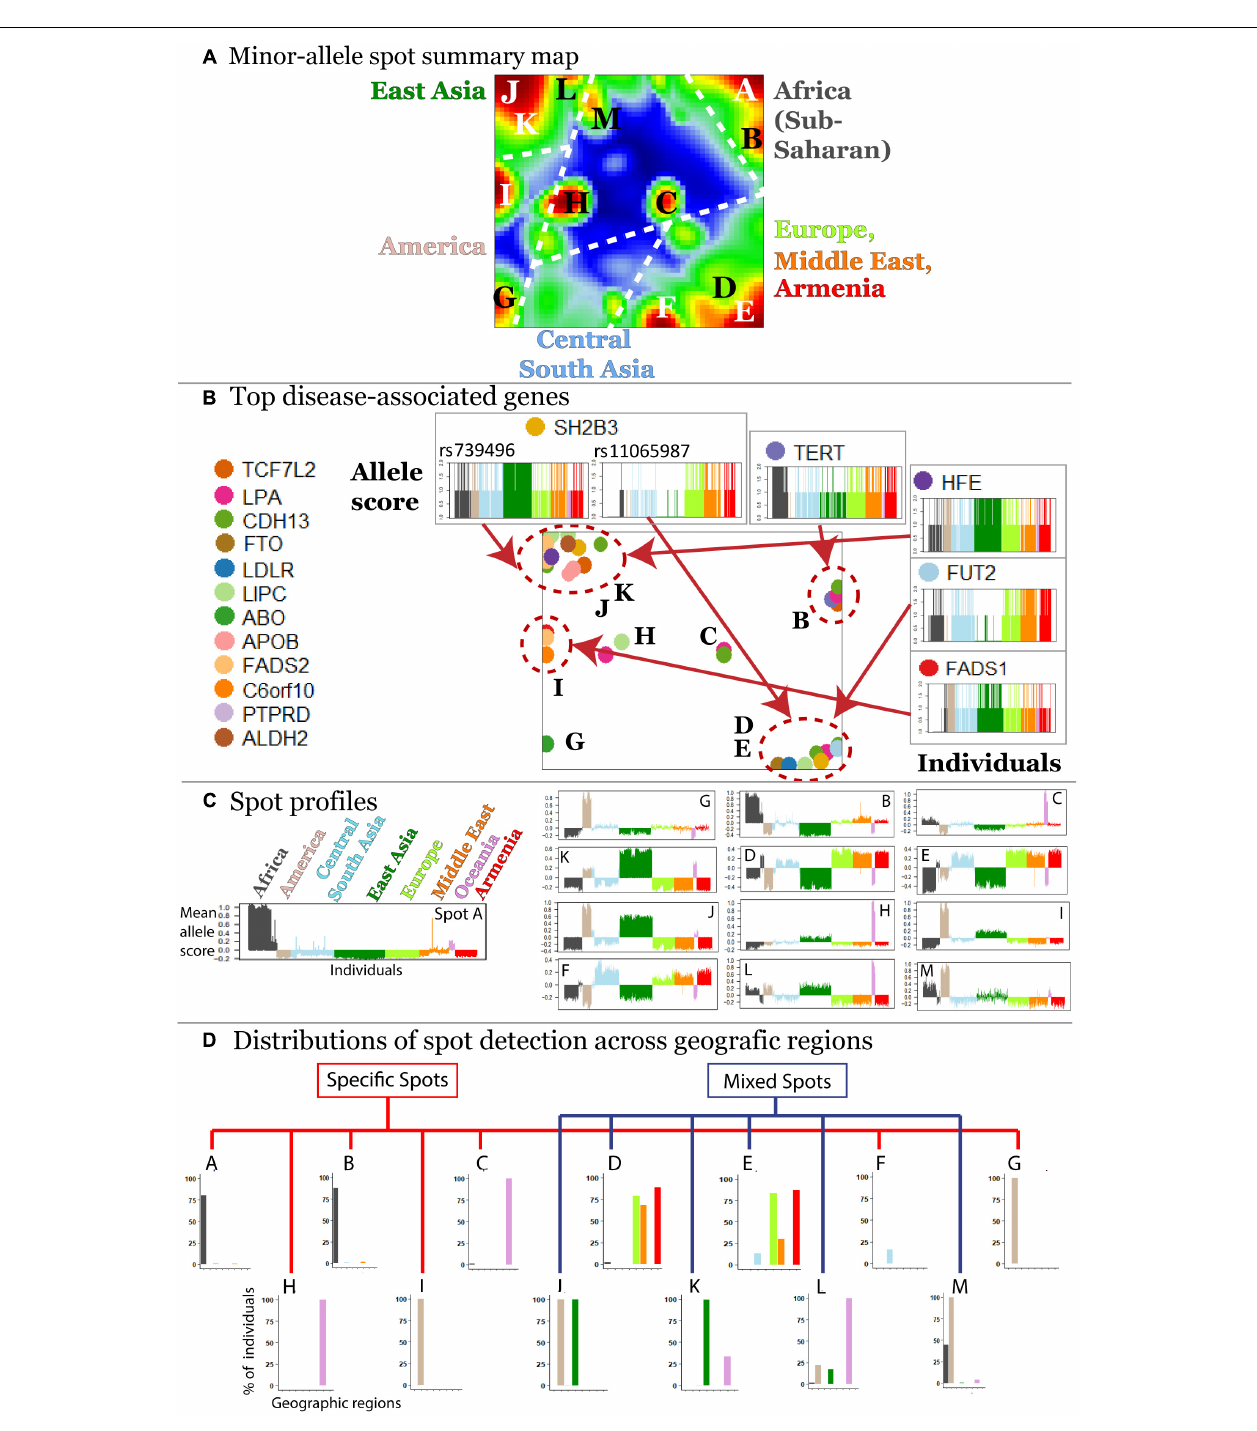
FIGURE 3 | Characterization of the SNP landscape. (A) The spot summary map segments into 13 spots (see labels A–M) enriching minor-alleles in a population/geography specific way. (B) The positions of 17 SNPs referring to different genes selected from the top 40 genes having a high number of disease associations (Price et al., 2015) in the SOM are indicated by arrows. Accumulation of these genes in the spot areas is indicated by dashed circles. The profiles of selected SNPs reveal a population-specific enrichment of minor-allelic scores. (C) Mean allele profiles of the SNPs collected in each of the spots are shown as barplots. Each of the spots refers to a different profile. (D) Part of the spots can be assigned to one geographic region while ‘mixed’ spots show enrichment of minor alleles in populations from more than one region (see also the mean portraits in Figure 2A ).